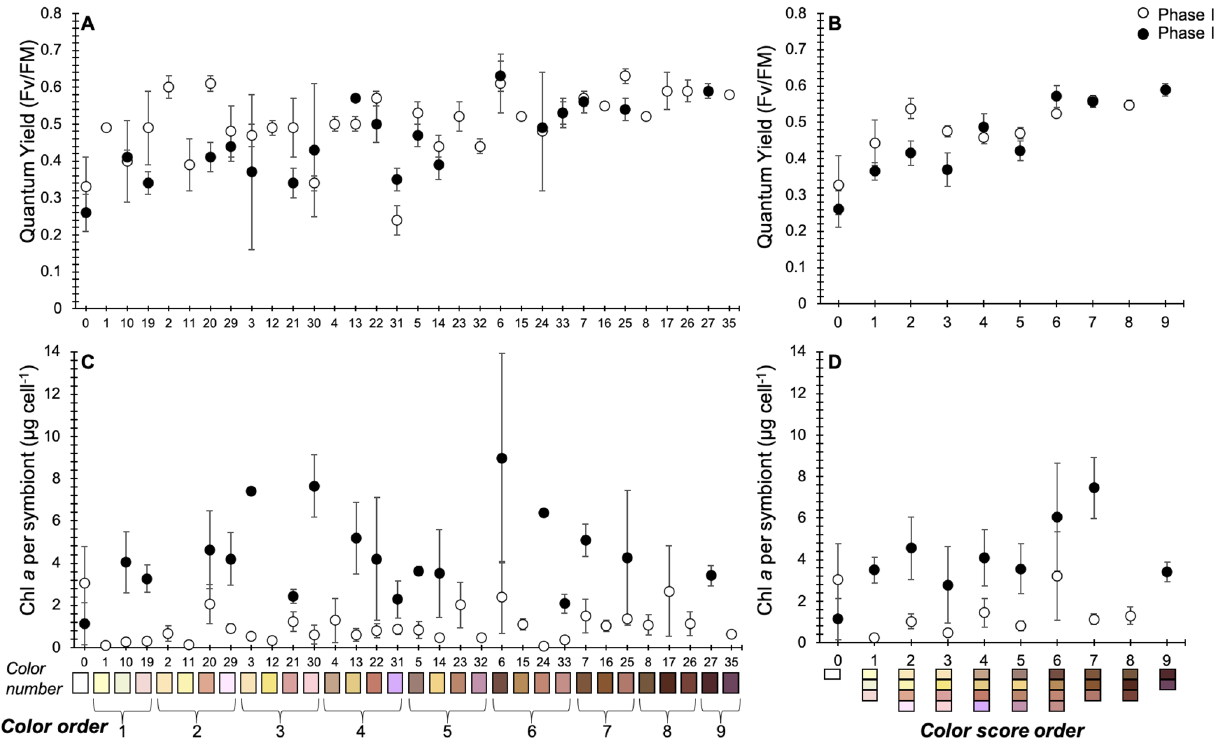
I (white circle) and Phase II (black circle) data. Mean coral health response is pooled across species and error bars represent SE of